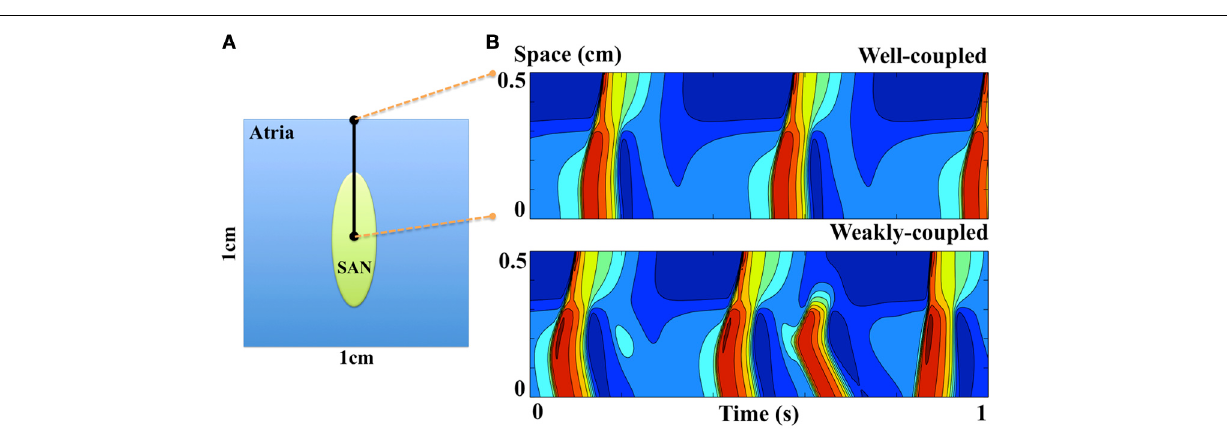
proximal (at 0cm) and distal (at 0.5cm) sites correspond to the central SAN cell and peripheral atrial cell respectively, indicated as black dots in (A)